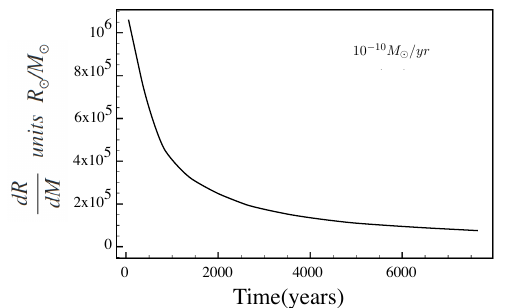
in units of M (cid:12) /τ KHR dM